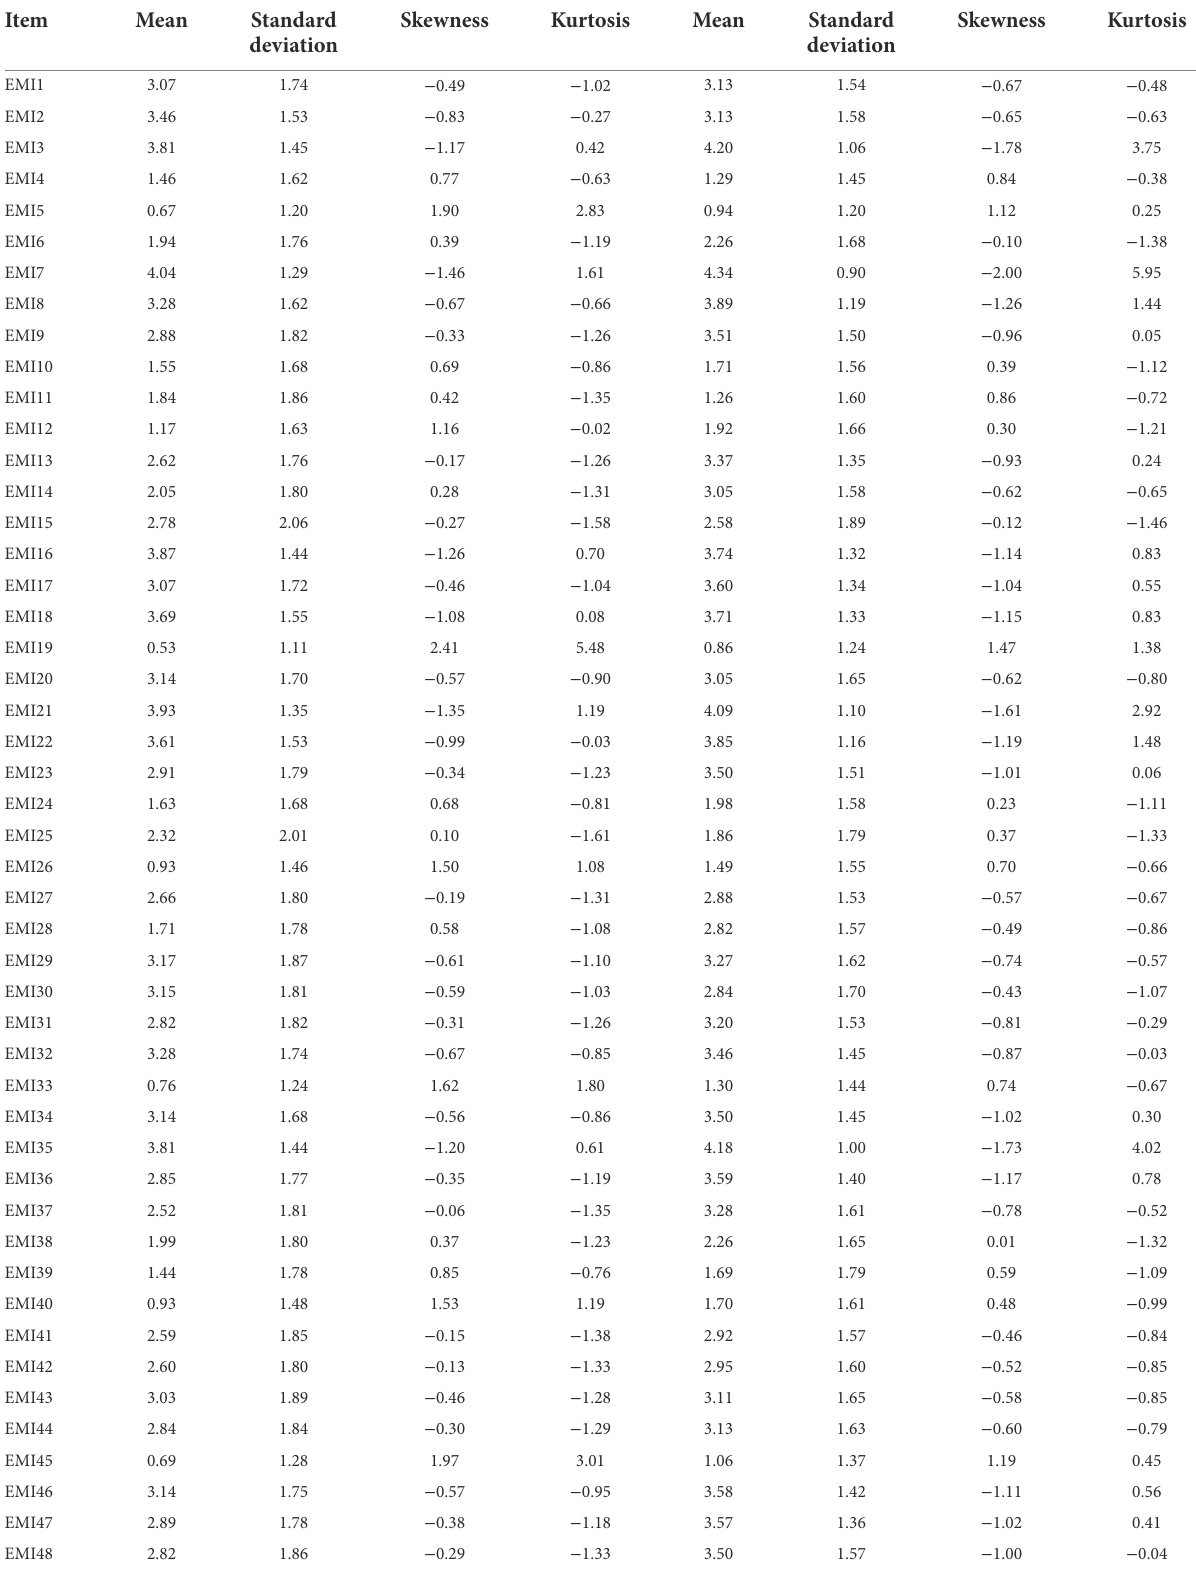
TABLE 1 Distribution of responses given to exercise motivations inventory 2 (EMI-2) items by Brazilian ( n = 1,000) and Portuguese ( n = 319)